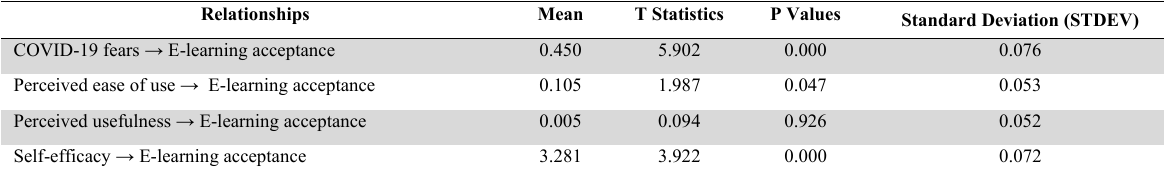
Results of the structural